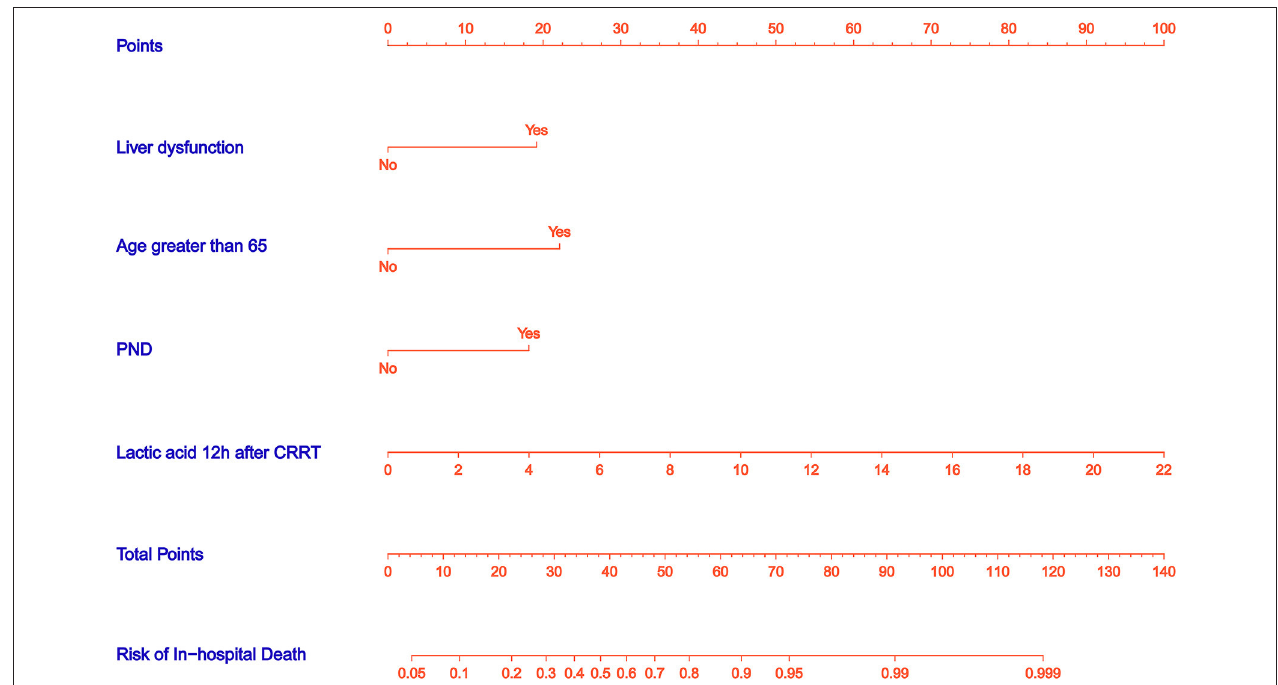
FIGURE 3 | Nomogram predicts in-hospital death risk in patients with postoperative AKI undergoing CRRT after ATAAD surgery. The nomogram was established to predict the risk of in-hospital death based on four independent prognostic factors. The total score can be calculated by summation of single scores. We can estimate the probability of in-hospital death by projecting the total score to the lower total point scale.